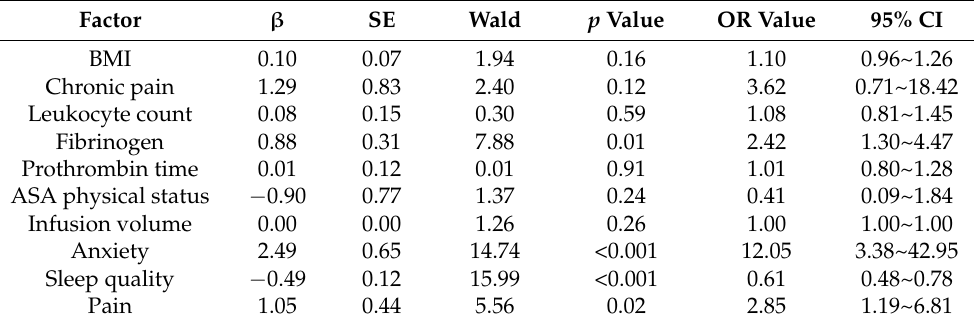
Table 3. Multivariate analysis of risk factors for depressive symptoms in elderly patients undergo- ing